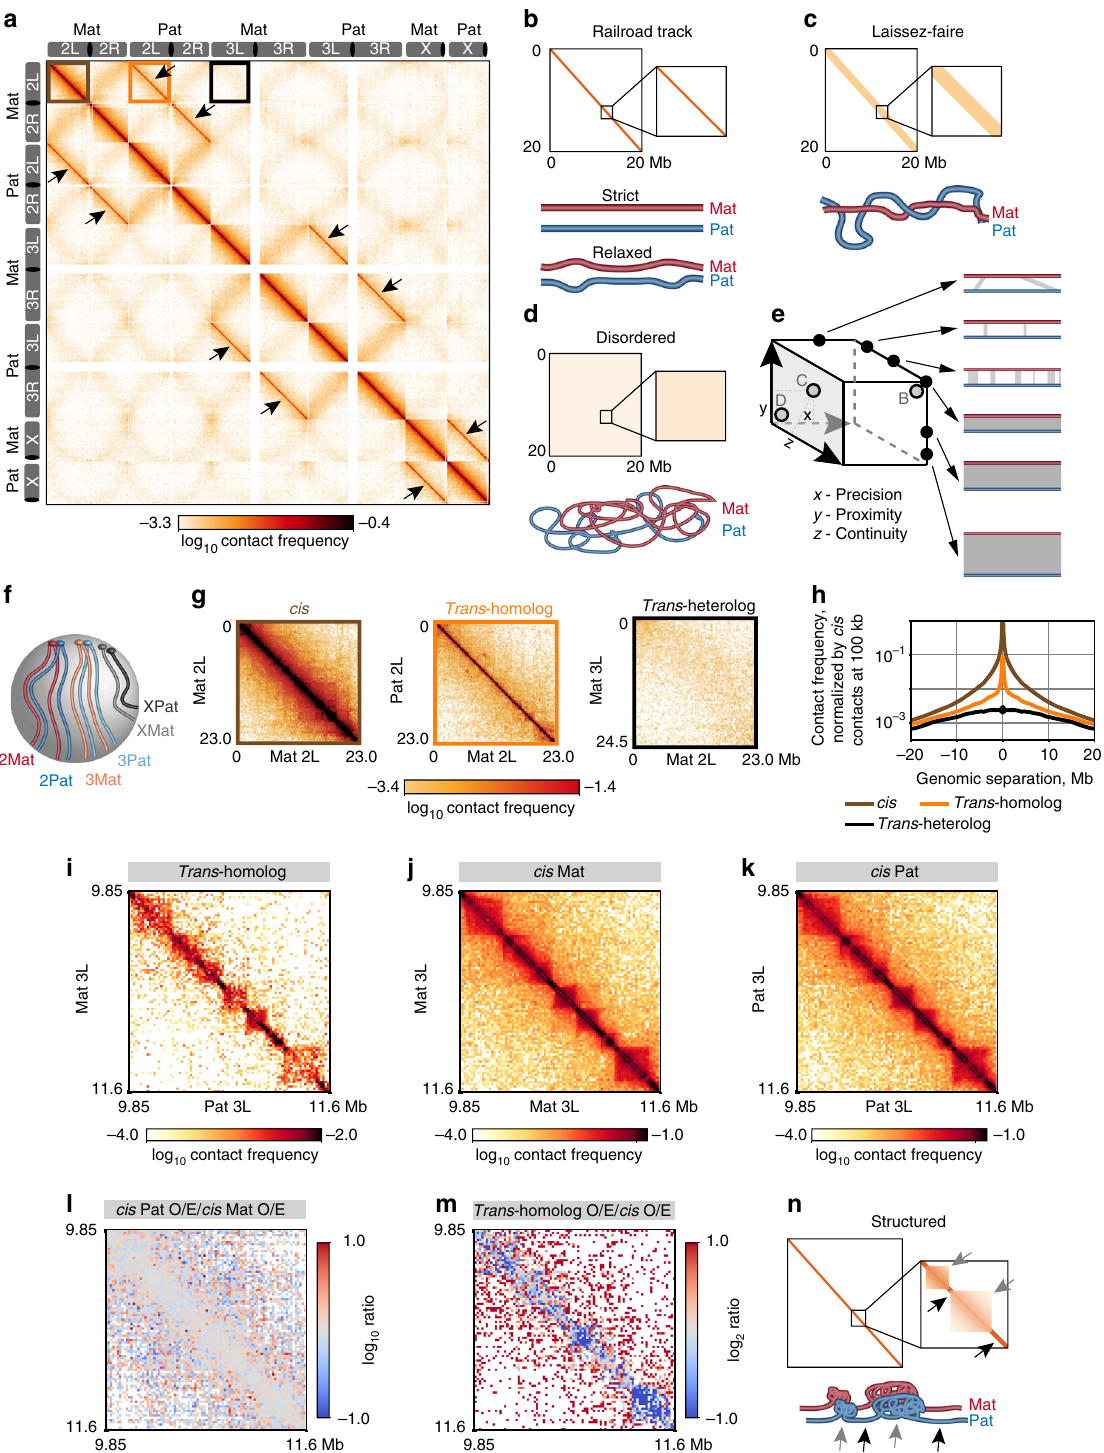
Fig. 3 Highly structured homolog pairing resembles features of cis -organization. a Haplotype-resolved Hi-C map of F1 hybrid embryos. Arrows, trans - homolog diagonals. b – d Homologs juxtaposed in a b railroad track fashion, c a loose, laissez-faire mode, or d a highly disordered structure. e Homolog pairing may encompass a range of structures de fi ned by precision, proximity, and continuity. f Rabl positioning of chromosomes. The g zoomed-in maps of chromosomal arms (color coded boxes in a; L, left; R, right) and h respective contact frequencies as a function of genomic distance (see Methods). i trans -homolog, j cis maternal, and k cis paternal maps of matching regions on chr3L. l Ratio of cis Pat/ cis Mat Hi-C maps indicates the cis contact patterns of two homologs are highly consistent. m The ratio of trans -homolog/average cis maps suggests that pairing resembles cis contacts, albeit with lower interactions in some regions (dark blue). n Homolog pairing displays highly structured trans -domains (black) and trans -boundaries